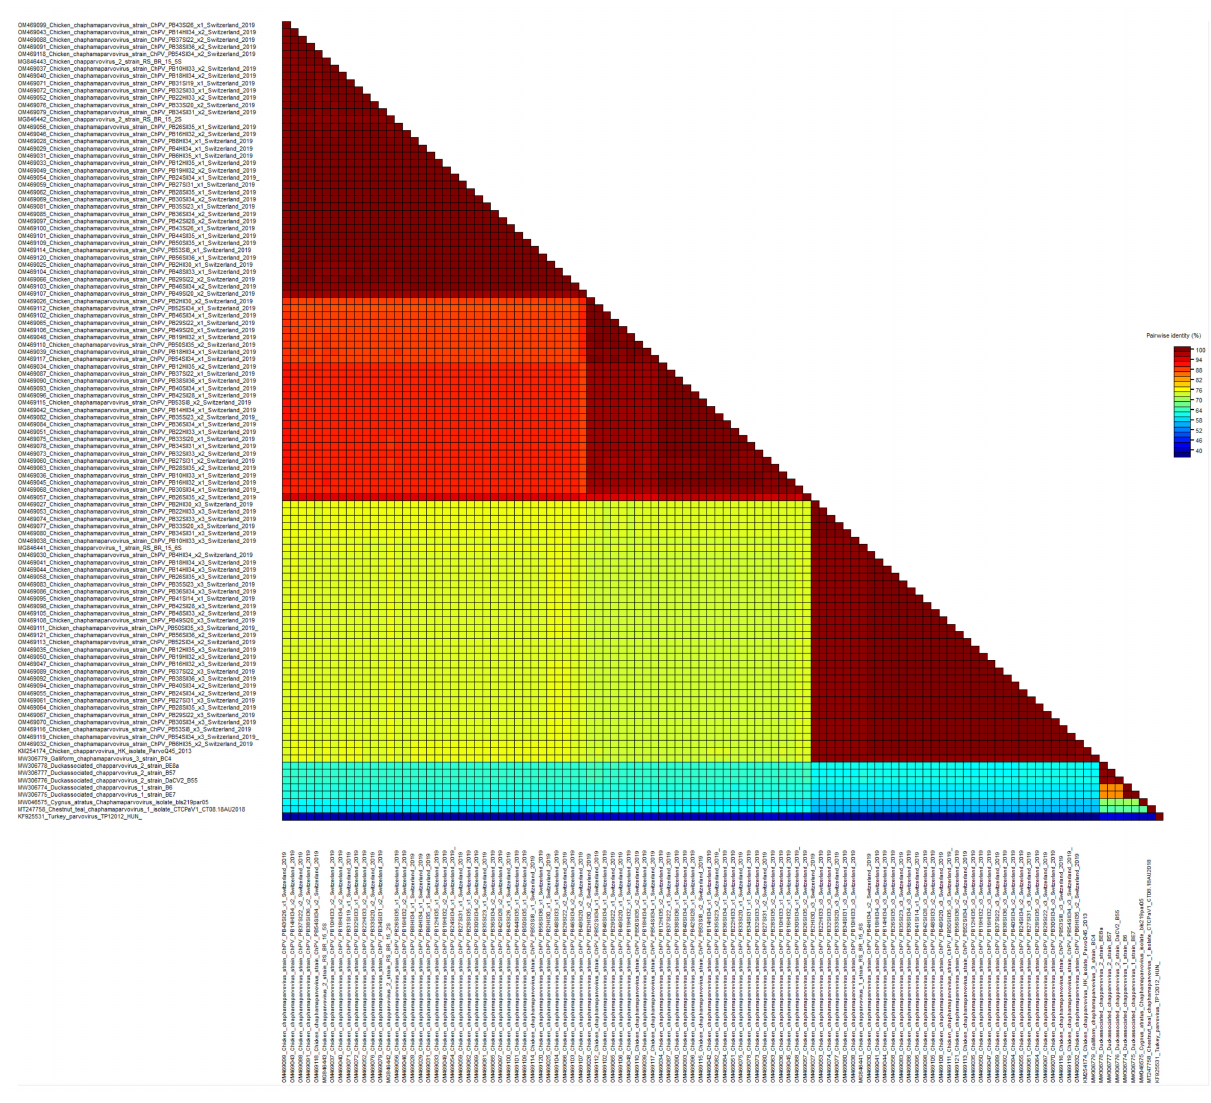
Figure 1. Color-coded matrix of pairwise sequence identity scores of the chaphamaparvoviruses NS1 protein generated with the Sequence Demarcation Tool ver. 1.2